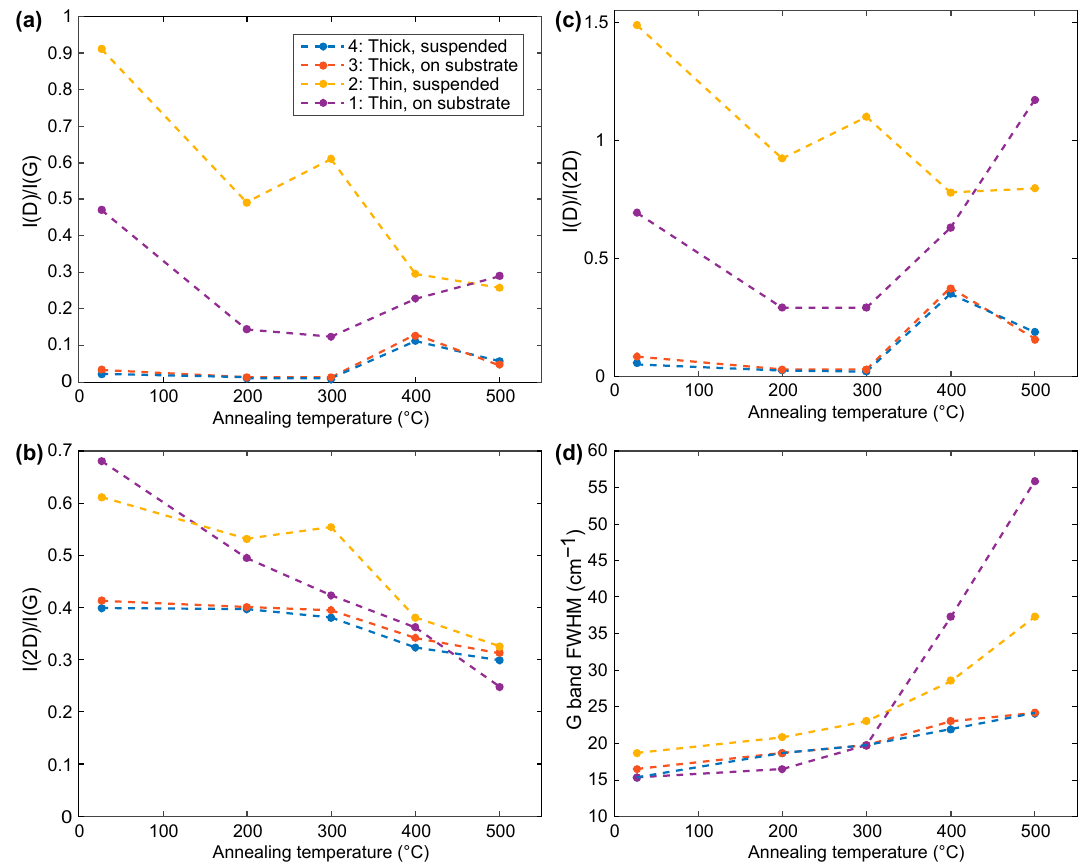
Figure 3. The ratio intensities of I(D)/I(G) in ( a ), I(2D)/I(G) ( b ), and I(D)/I(2D) ( c ) of graphene sheet with different locations before and after annealing at different annealing temperatures; ( d ) G band full width at half maximum (FWHM) of graphene sheets with different locations before and after annealing at different annealing temperatures, the FWHM of the G band was fitted using the Lorentzian function—dashed lines aid the reader to see overlapping points.